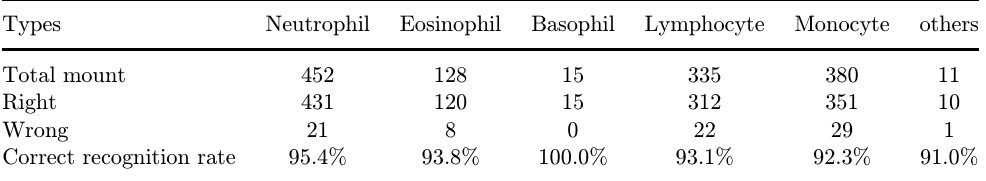
Table 6. Recognition rate with ICT.